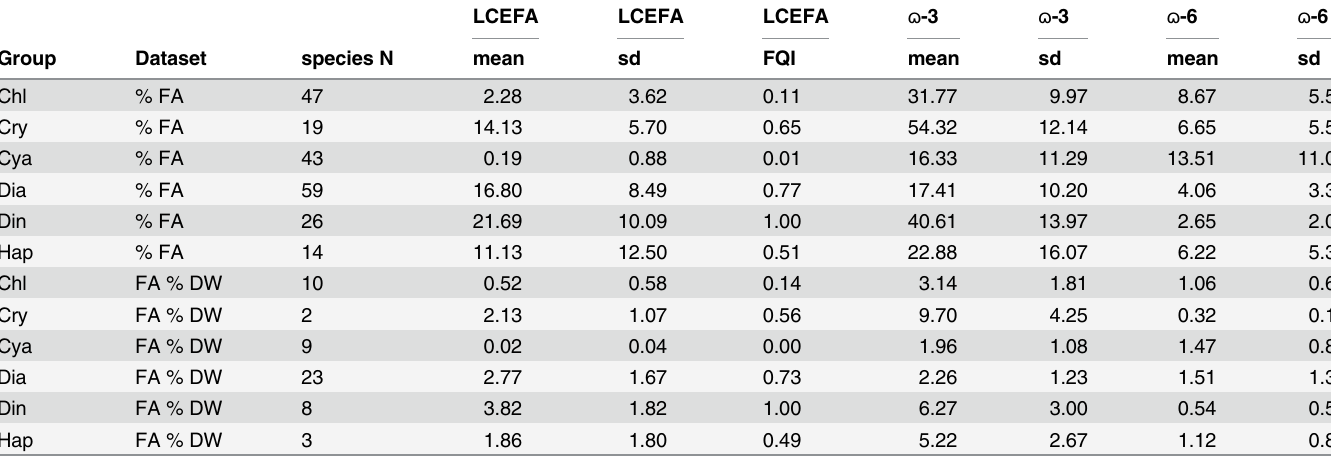
Table 2. Summary of % LCEFA, % ɷ -3, and % ɷ -6 by phytoplankton group and